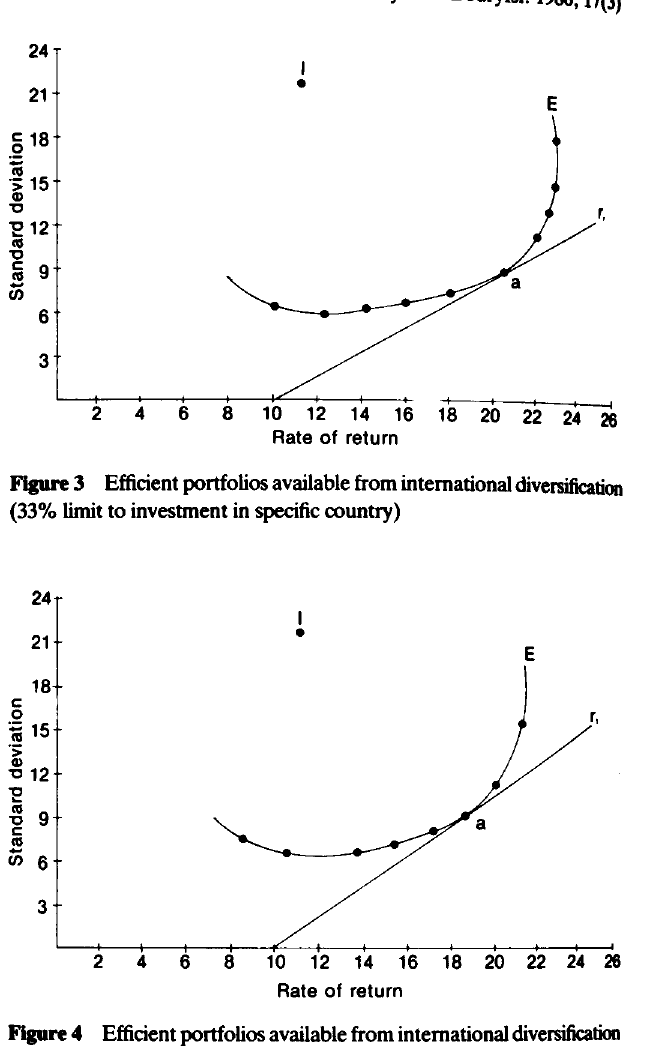
Figure 4 Efficient portfolios available from international diversification (20% limit to investment in specific country)